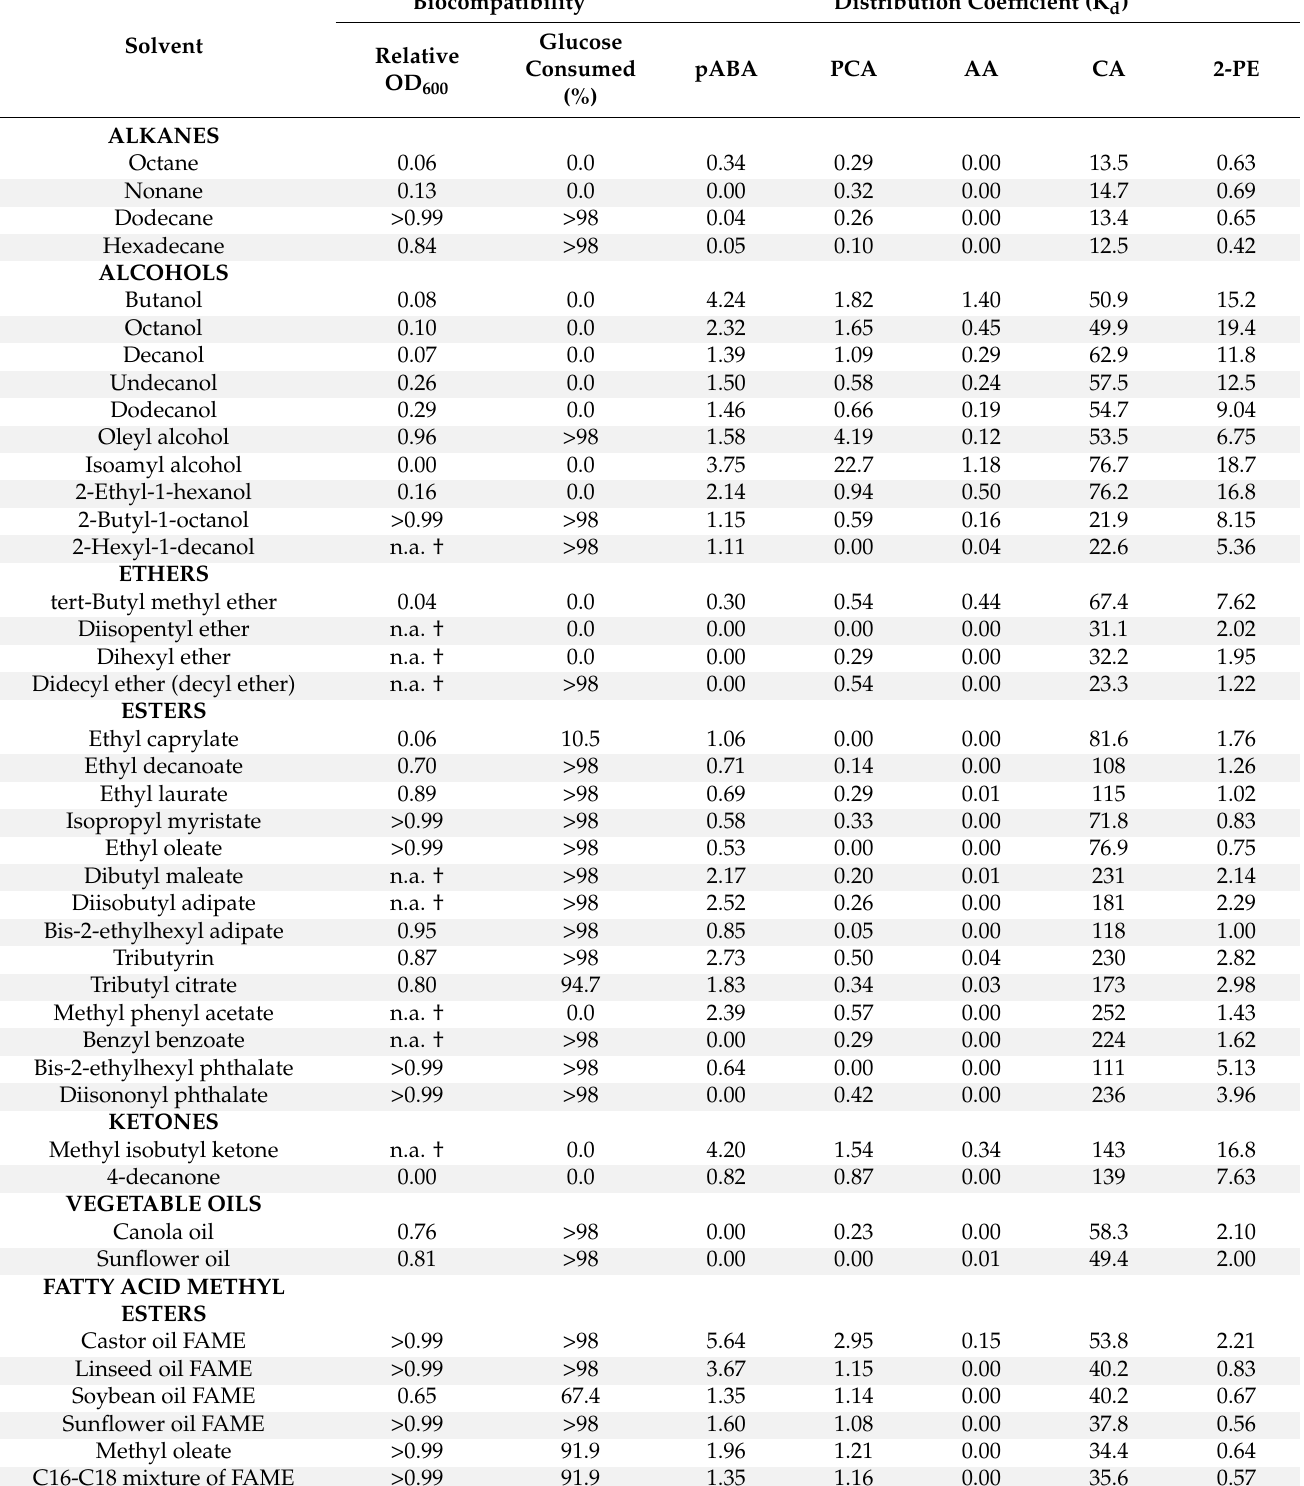
Table 1. Biocompatibility and distribution coefficients of single solvents for para -aminobenzoic acid (pABA), protocatechuic acid (PCA), adipic acid (AA), trans -cinnamaldehyde (CA) and 2-phenylethanol